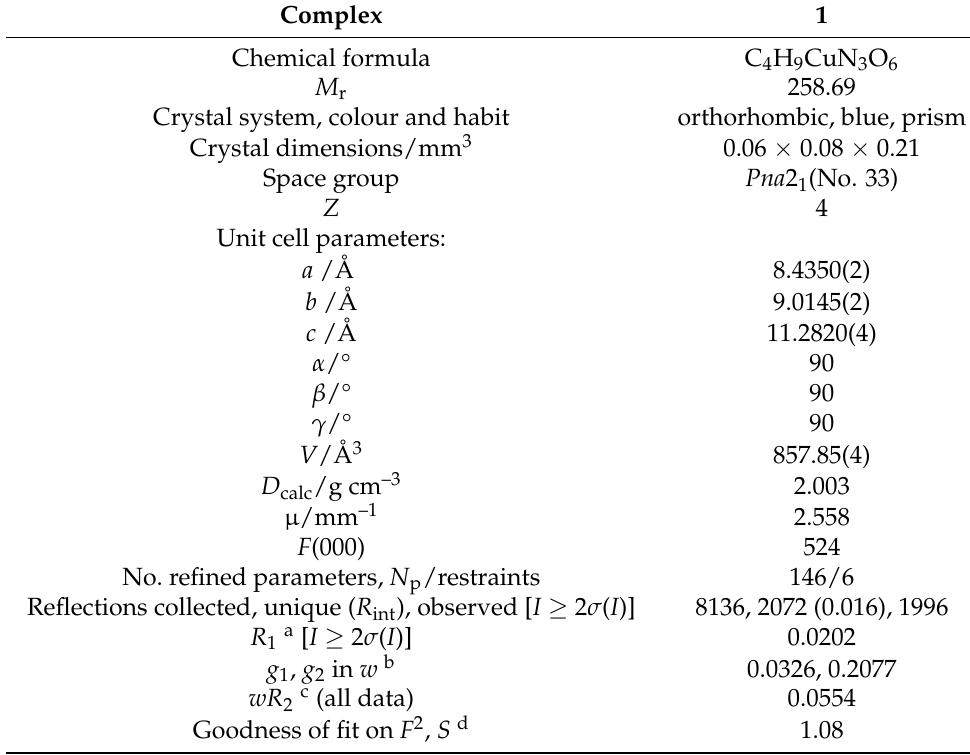
Figure A1. Comparison of the powder pattern for the synthesized material and the pattern simulated from the single crystal data (CSD Refcode: YUKVOQ) [18]. Table A1. Crystallographic data for compound 1